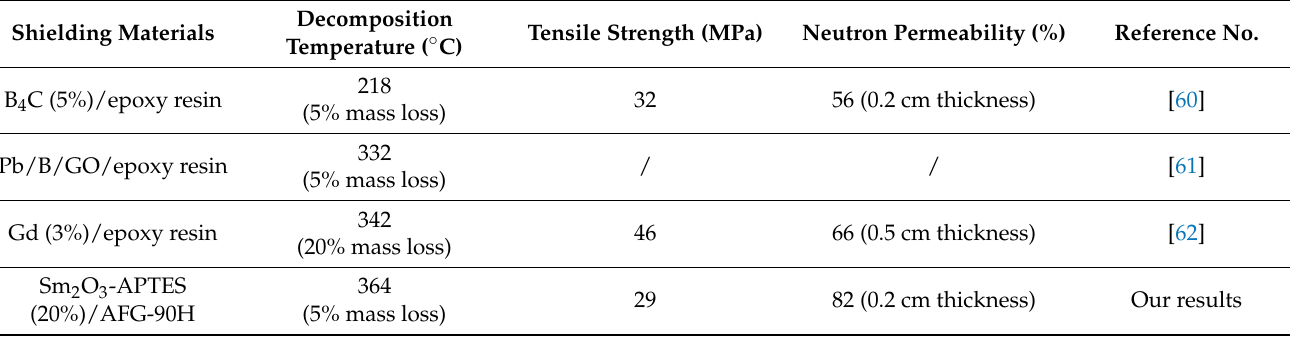
Table 4. The decomposition temperature of different mass loss, tensile strength, neutron permeability of epoxy-based neutron shielding